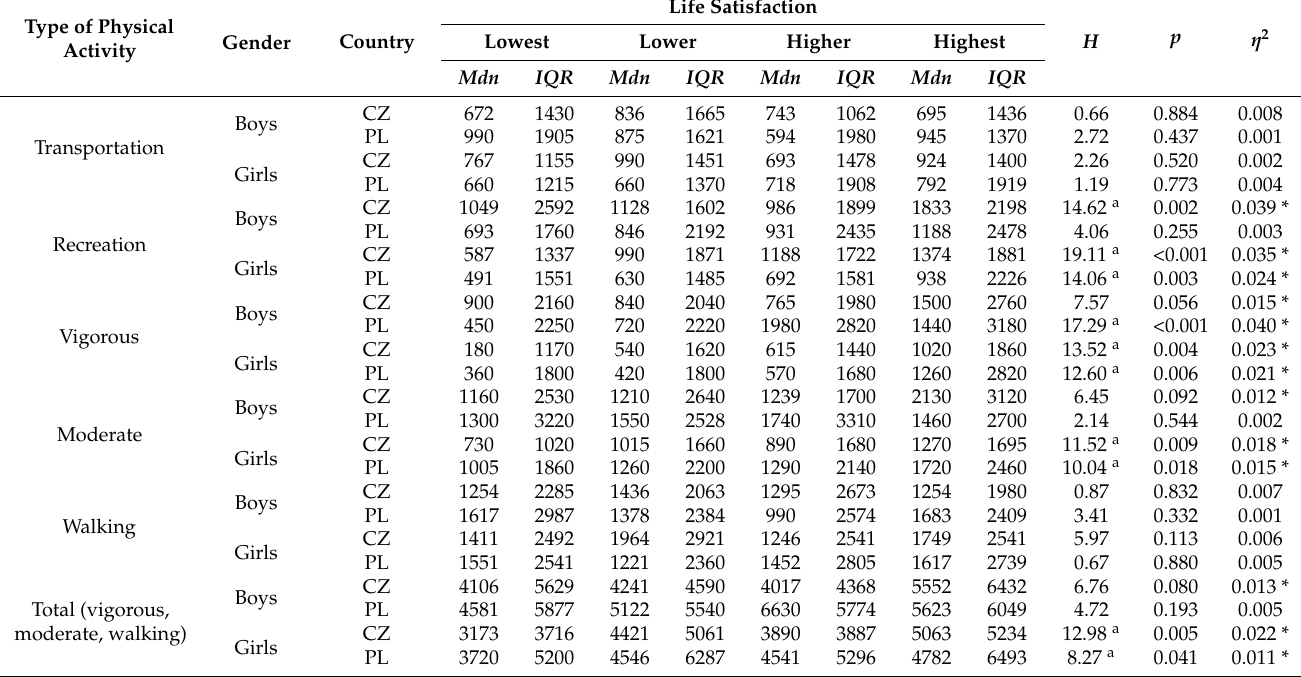
Table 2. Associations between life satisfaction (lowest, lower, higher, and highest) and types of weekly physical activity (MET-min) among Czech and Polish boys (CZ n = 302, PL n = 361) and girls (CZ n = 466, PL n = 467). Type of Physical